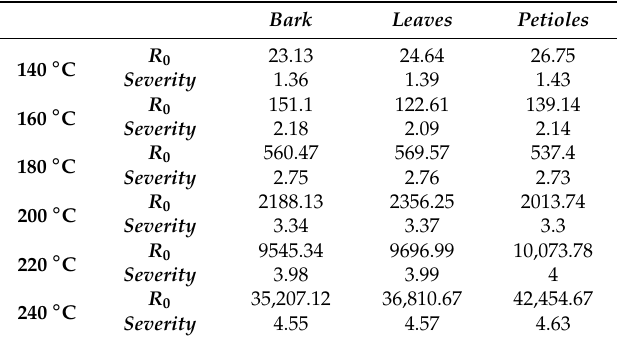
Table 1. Severity factor of autohydrolysis extraction of di ff erent parts of Paulownia.